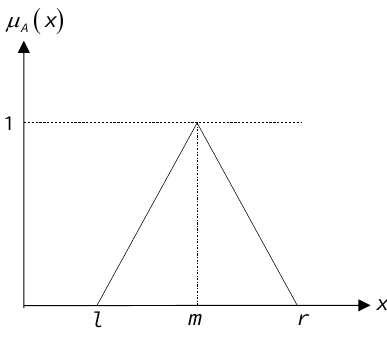
Figure 5. The attribution function.